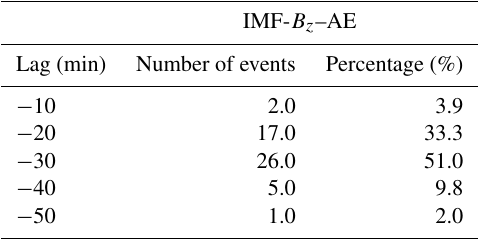
Table 3. Distribution of the intervals of lag between IMF B z com- ponent and the AE